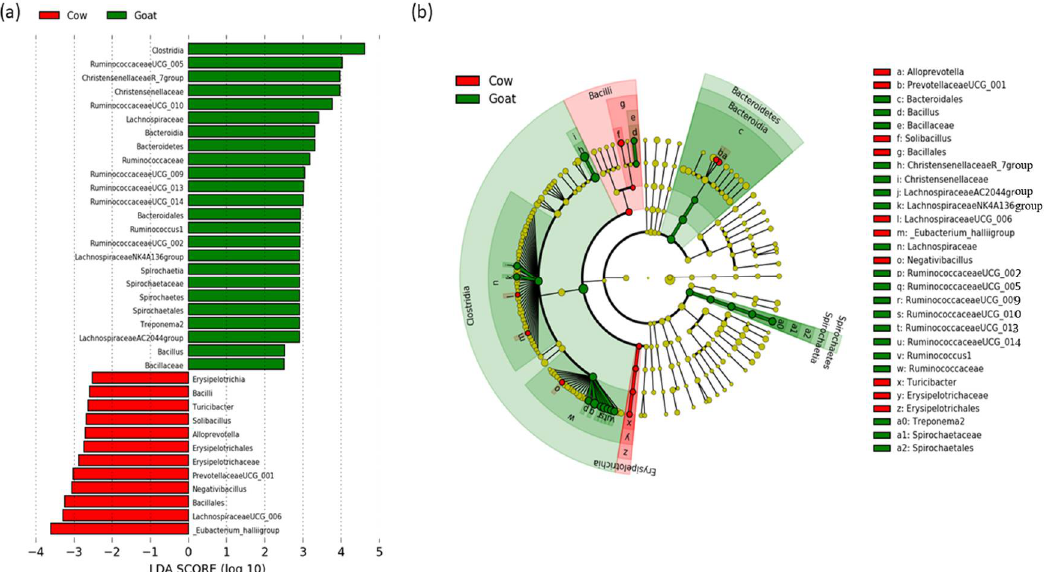
Figure 4. Linear discriminant analysis (LDA) scores for 36 bacterial phylotypes with significantly dif- ferent abundances in cow and goat fecal samples. ( a ) The bar length represents the log10-transformed LDA score indicated by the vertical dotted lines. Negative (red bars) LDA scores represent bacterial taxa overabundant in cows, while positive (green bars) bacterial taxa are overabundant in goats. ( b ) Cladogram showing the differences in enriched taxa in cows (red) and goats